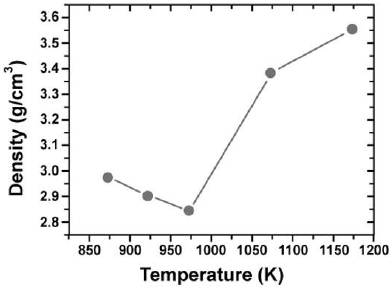
Figure 25. Change of density as a function of temperature at 690 MPa.